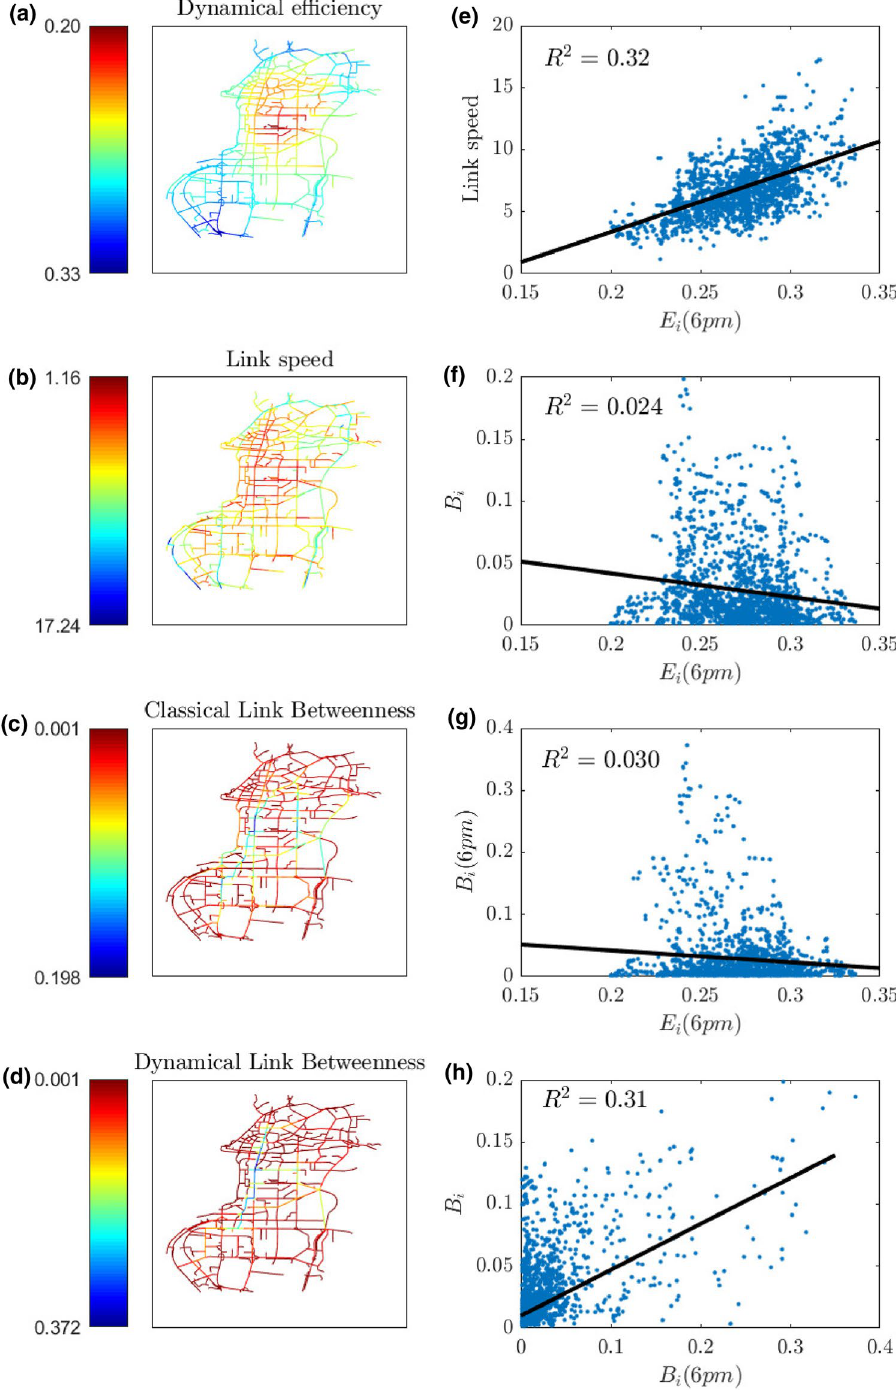
Figure 4. Comparison of the dynamical efficiency to betweenness and link speed. Panels ( a )–( d ) show the spatial distribution of the link values at 6pm for: dynamical efficiency, link speed, betweenness centrality and dynamical betweenness respectively. The scatter plots in panels ( e ) through ( g ) show the correlations between the dynamical efficiency and the other measures, while that in ( h ) refers to the correlation between classical and dynamical betweenness. Each blue point represents a link, while the black line is the linear regression of the plotted data. In each panel the value of the R 2 of the corresponding linear regression is also